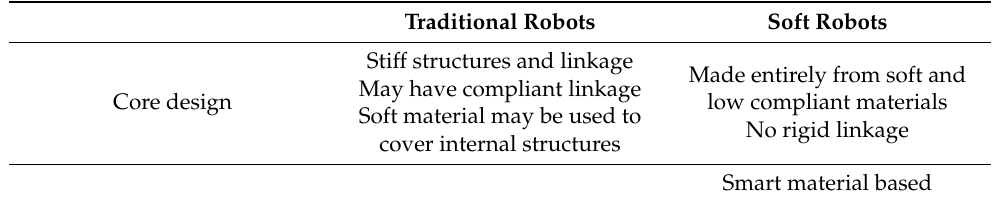
Table 1. Traditional robots vs soft